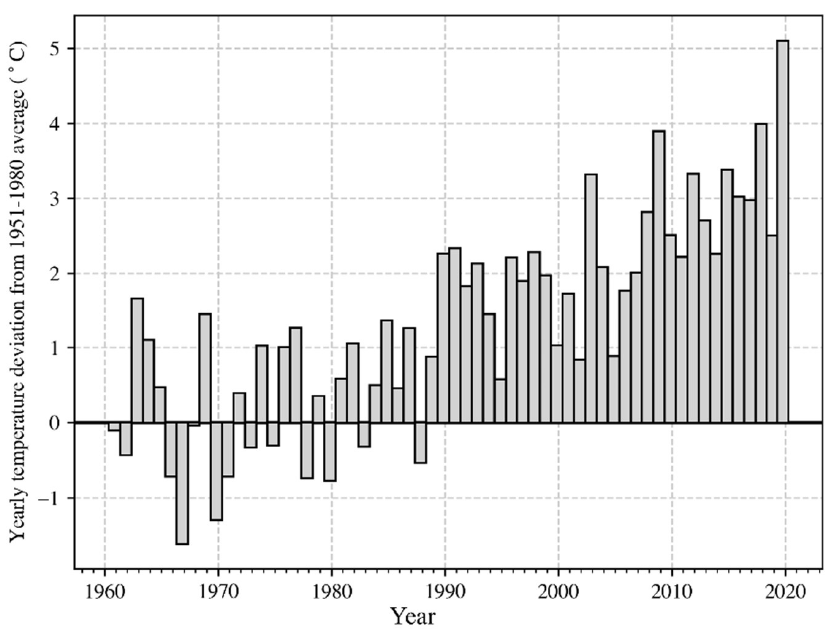
Figure 9. Deviation of mean annual temperature from 1951–1980 average since 1960. Data is from the meteorological station of Yakutsk (World Metrological Organization Index: 24959; 62.0866°N, 129.7500°E).